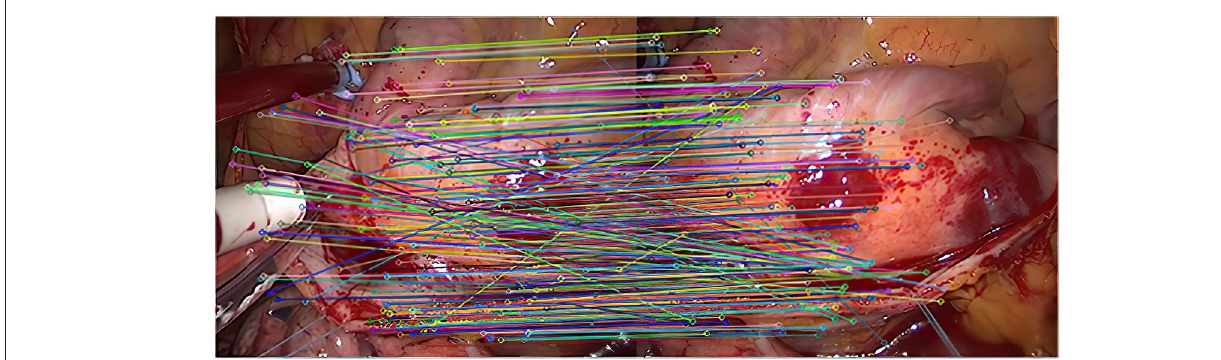
FIGURE 2 | The first matching result of feature points.